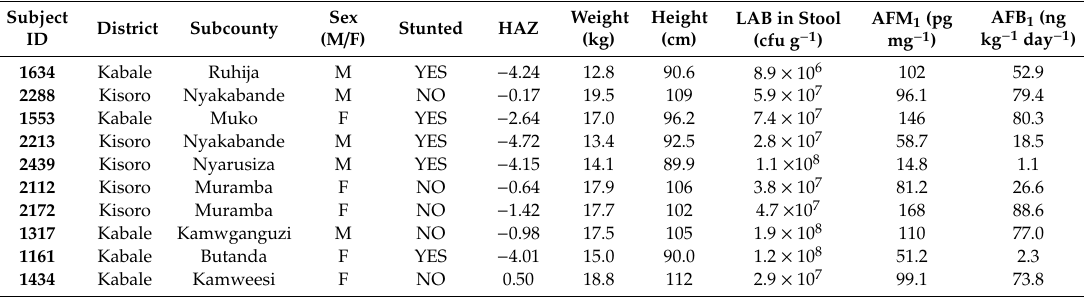
Table 1. Height-for-age Z -scores (HAZ), weight, height, lactic acid bacteria (LAB) in stool and mycotoxin concentration in urine (AFM 1 , aflatoxin M 1 ), and estimated daily aflatoxin intake (AFB 1 , aflatoxin B 1 ) of ten Ugandan children from Kabale and Kisoro, southwestern Uganda, at the age of 54–60 months. Values for lactic acid bacteria (LAB) in stool and AFM 1 are means of three independent experiments. The estimated daily aflatoxin intake levels were based on measured AFB 1 levels in maize and peanut in each subcounty (the means are presented in Figure